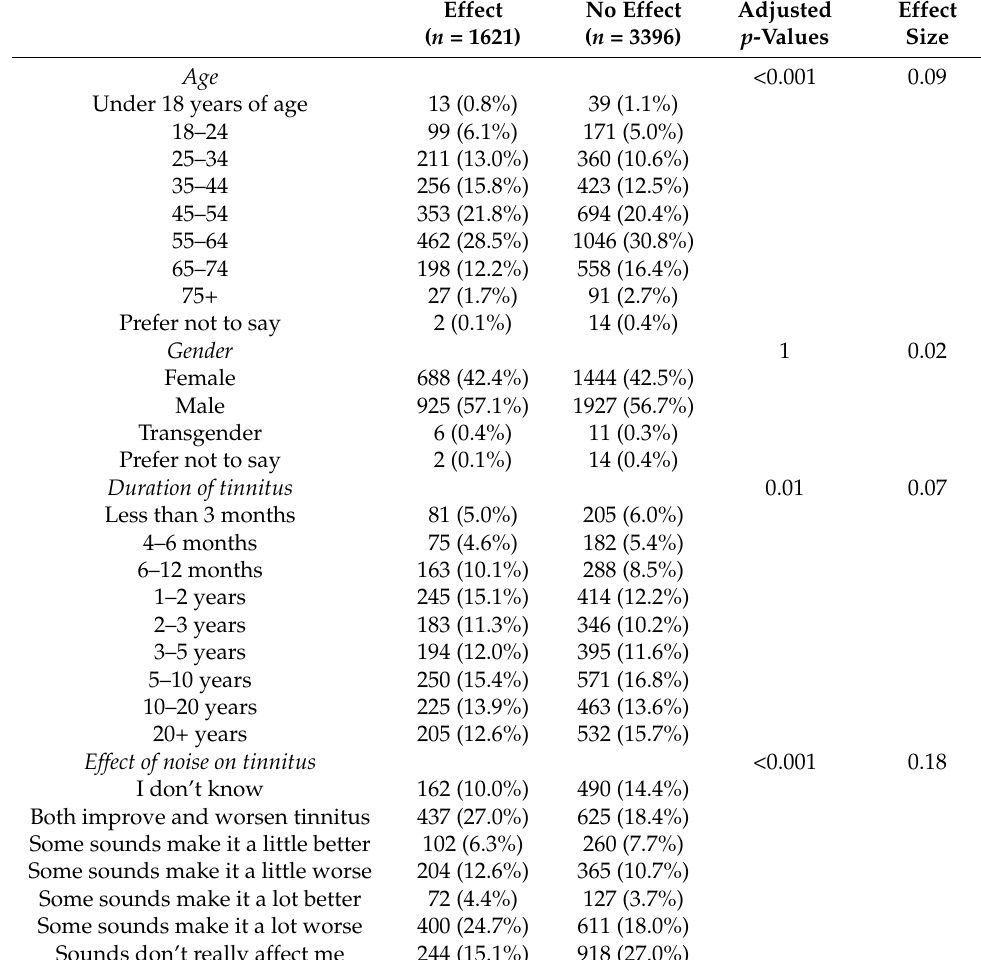
Table 1. Participant demographics, reported comorbidities, and tinnitus characteristics. Data were stratified based on the reported effect of dietary items on tinnitus. All p -values were corrected for multiple comparisons using the Holm method. Effect sizes were calculated using Cramer’s